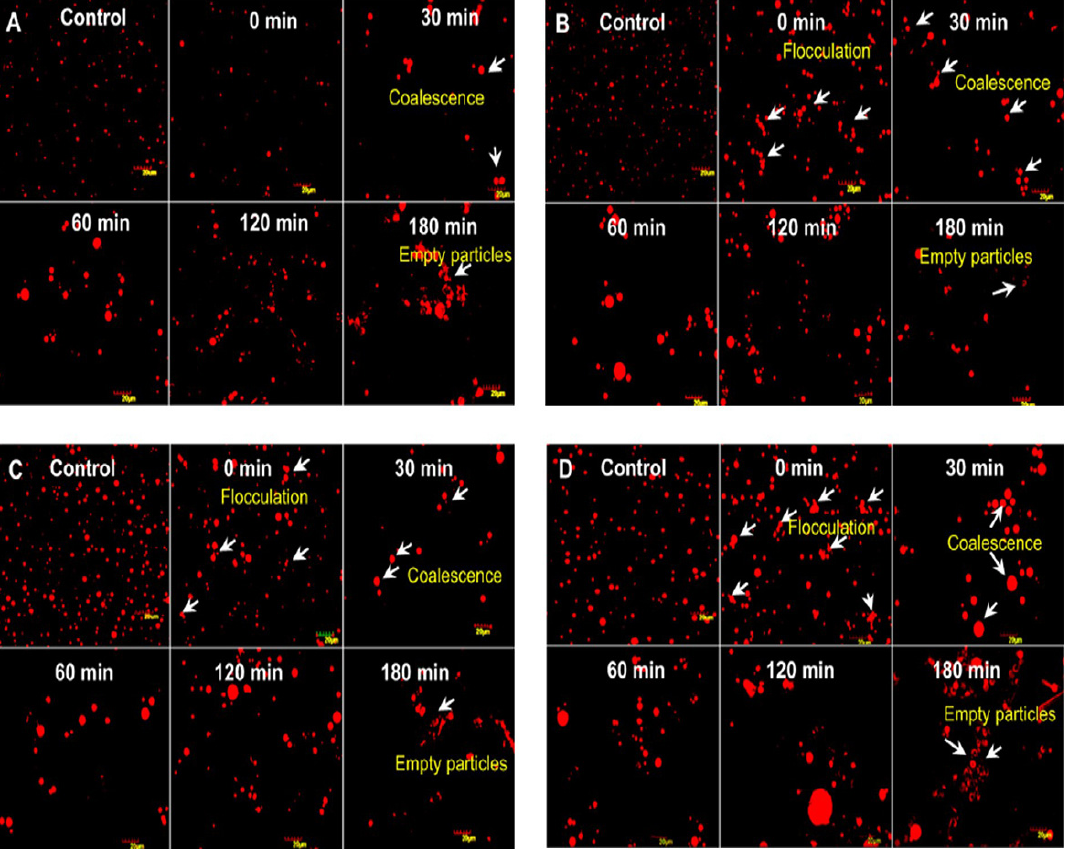
Figure 3. Comparison of different milk fat globules: camel ( A ), goat ( B ), cow ( C ), and buffalo ( D ) by confocal microscopy. Adapted with permission from ref. [10]. Copyright 2014 Elsevier.